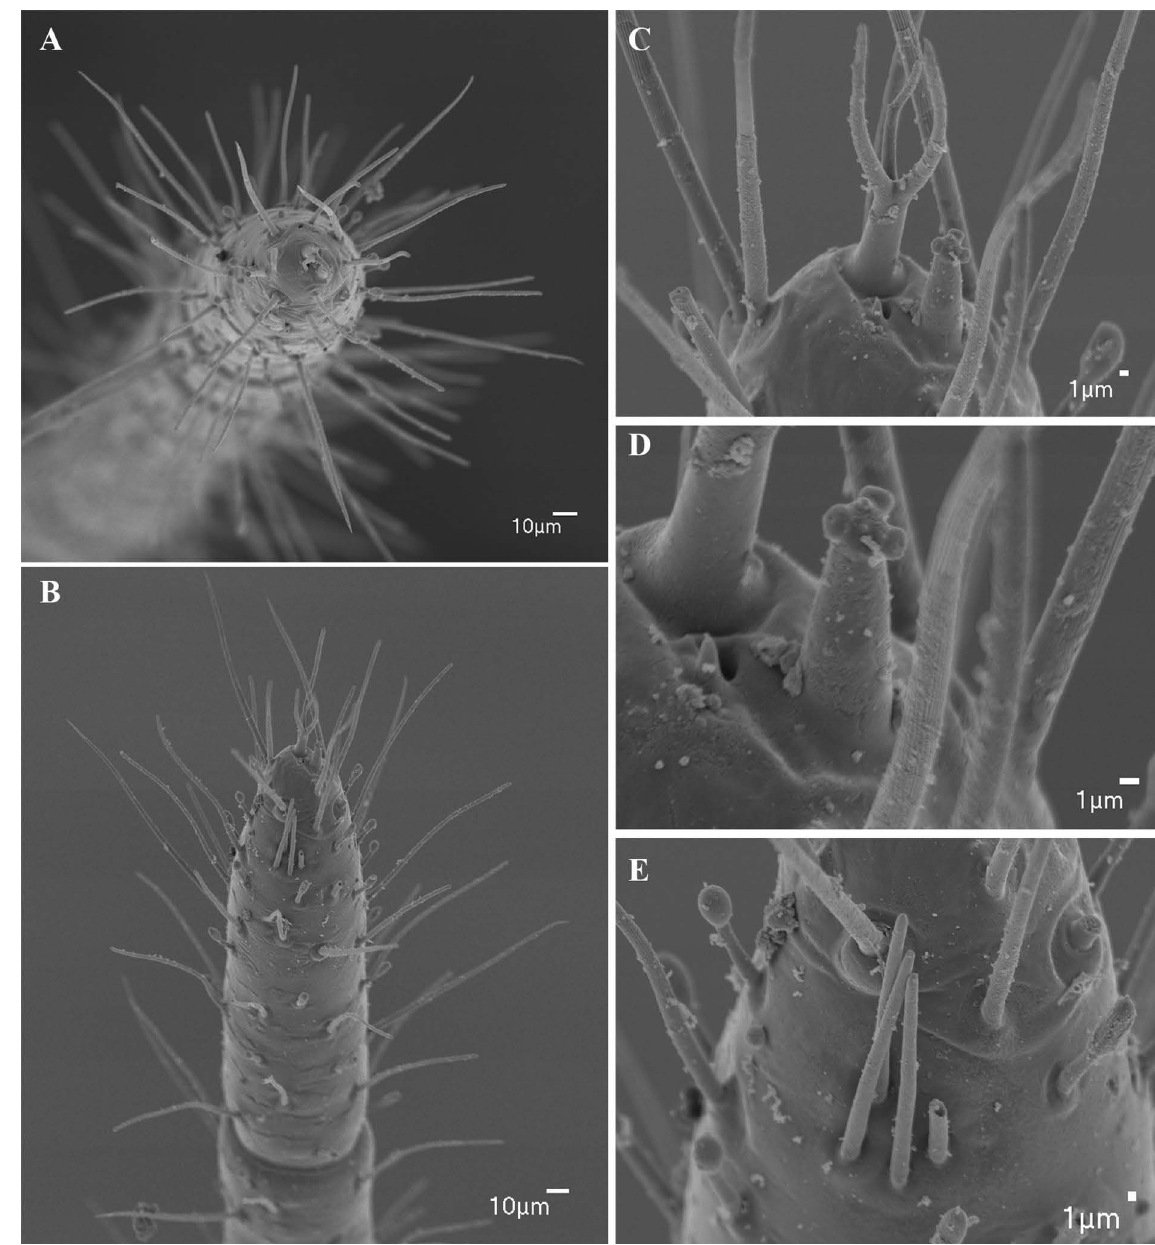
Fig. 16. Charinus aguayoi Moyá-Guzman, 2009 (USNM 785110), antenniform leg I, ♀. A . Apex of distal article. B . Distal segment of tarsus, lateral view. C . Apex of distal article of tarsus showing claw and tarsal organ. D . Detail of tarsal organ. E . Rod sensilla and olfactory setae.